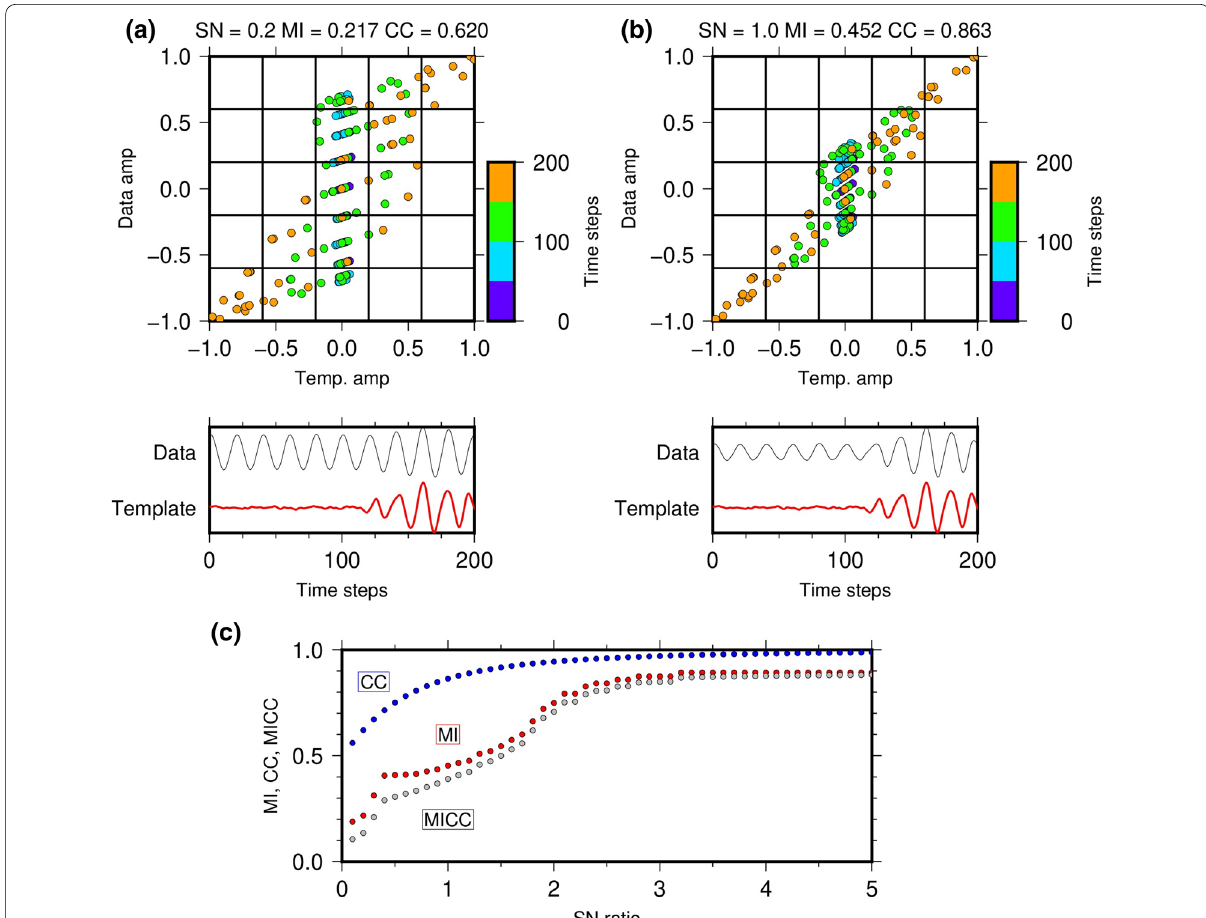
Fig. 6 Scatter plots and relationship between the SN ratio of the waveform and the MI, CC, and MICC for the synthetic waveform with sinusoidal noise. The figures are as in Fig. 4, but here the noise is a sinusoidal wave of frequency 1.25